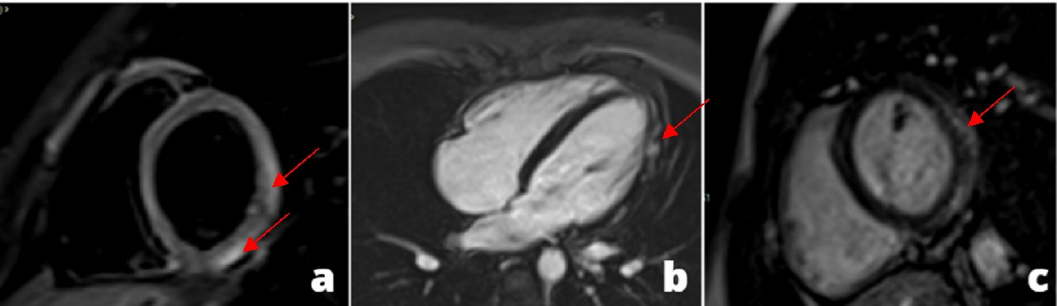
Figure 1. A young adult presenting at emergency department with acute chest pain, subtle ST alterations in the lateral wall of the left ventricle and cardiac enzymes elevation. Cardiac MRI was performed 48 h later demonstrating edema in the inferior-lateral wall of the left ventricle ( a ) associated with hyperemia in early gadolinium enhancement ( b ) and post-inflammatory fibrosis using late gadolinium enhancement sequences ( c ).